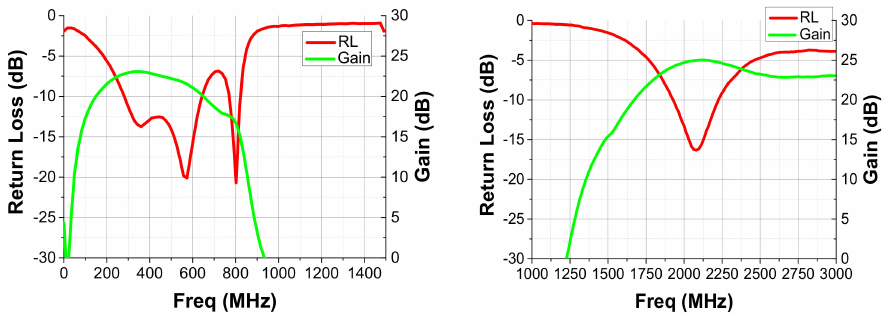
Figure 20. Measured results of the 4-layer stacked 3DHI RF front-end